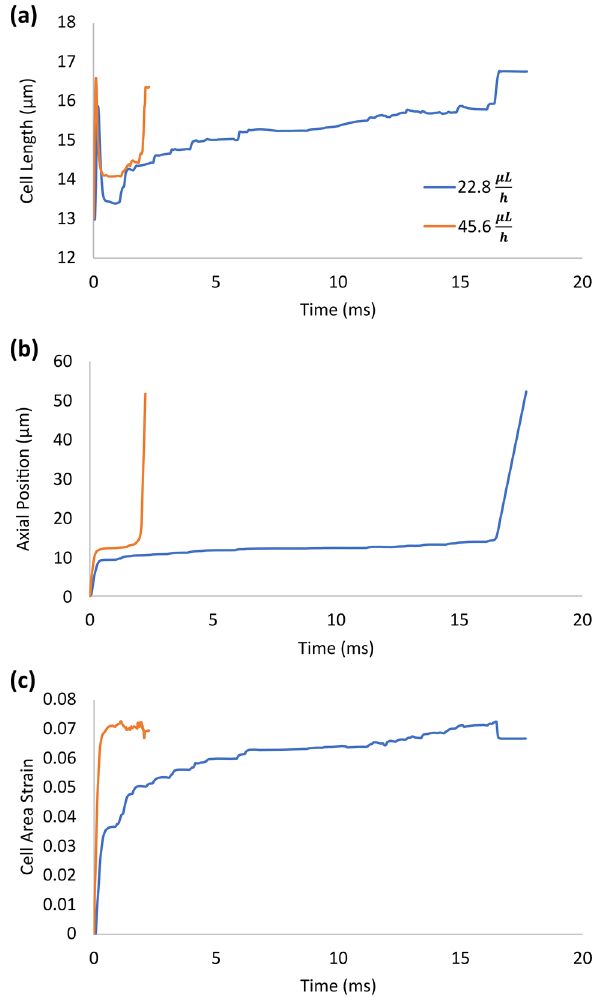
Figure 4. Comparison of deformation and motion of a lung cancer (H1975) in a microfluidic channel at two flow rates of 22.8 and 45.6 µL/h. ( a ) evolution of the cell length as the cancer cell advanced in the microchannel, ( b ) motion of the cell in the microchannel represented by the trajectories of its centre of mass, and ( c ) evolution of the area strain of the cell (change in the cell area relative to its undeformed shape divided by its undeformed initial area) as the cell advanced in the microchannel. The evolution of the cell at the low flow rate and the steps are marked in Fig. 3 and here it is shown for reference. The cell underwent a higher initial elongation and area strain in Step i with the high flow rate than it did with the low flow rate. The initial high area-strain value, that the cell reached to in Step i with the high flow rate, stayed almost constant during the entry steps. However, with the low flow rate, the area strain gradually increased during the entry steps until it eventually reached to the high value that the cell reached to Step i with the high flow